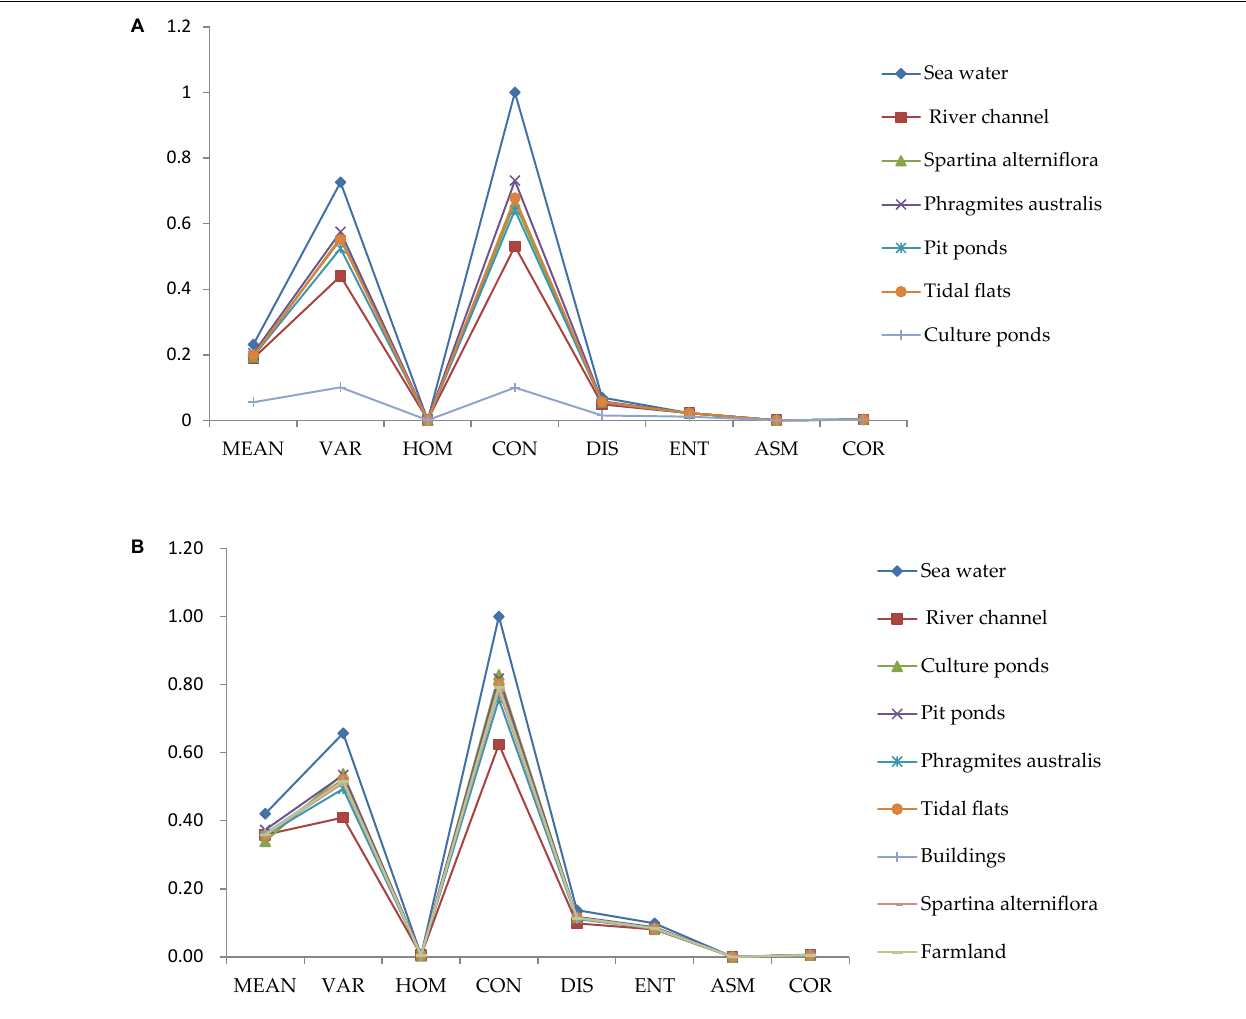
classification accuracy of the joint features was the